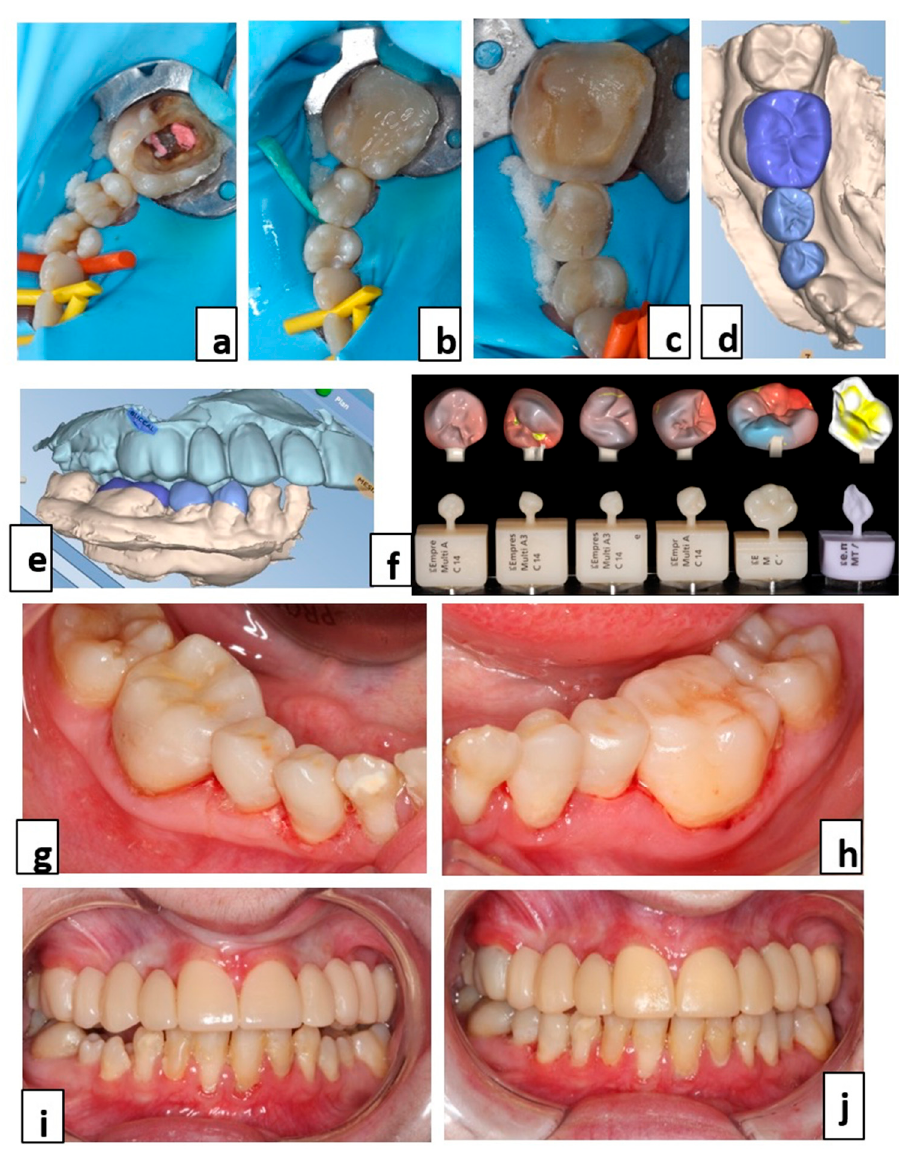
Figure 5. Mandibular rehabilitation in the posterior region and lateral infraocclusion correction. ( a – c ) Preparations of the lateral mandibular premolar and molar regions before optical impression; ( d – f ) digital modelling of prosthetic parts; and ( g , h ) final bonded restorations (intraoral frontal view before ( i ) and after ( j ) correction of lateral infraocclusions).